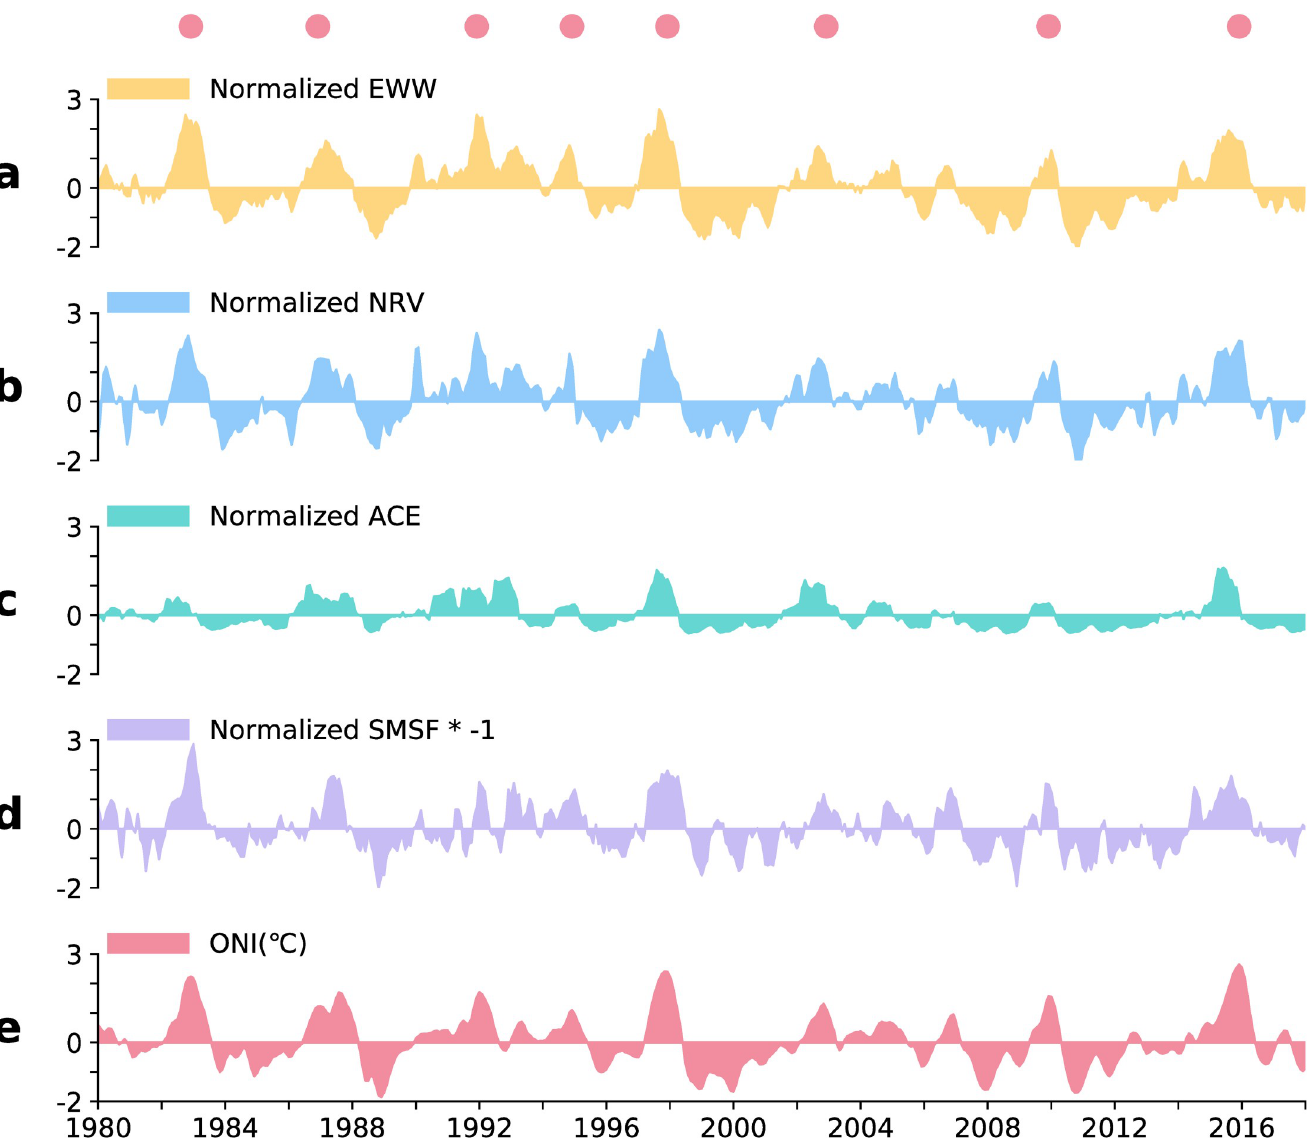
Fig 4. Inter-annual changes in various variables from 1980 to 2018: a, interannual change of EWW; b, interannual change of NRV; c, interannual change of ACE; d, interannual change of MCA; e, interannual change of ONI (˚C). All variables except ONI are standardised. The red dots represent the 1982–83, 1986–87,